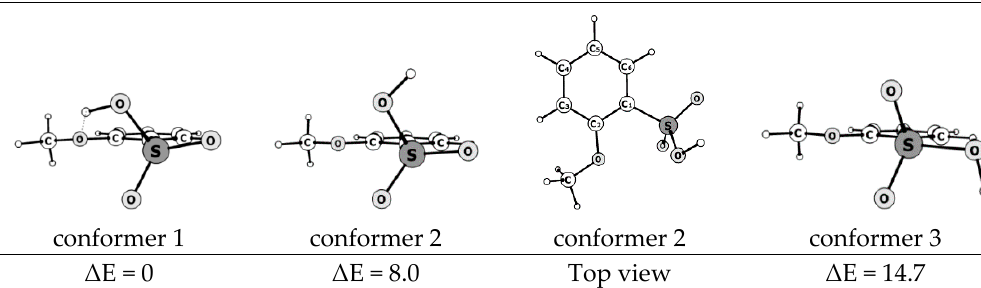
Figure 7. The structure of the 2-OCH 3 -BSA conformers and their relative energies ( ∆ E, kJ mol − 1